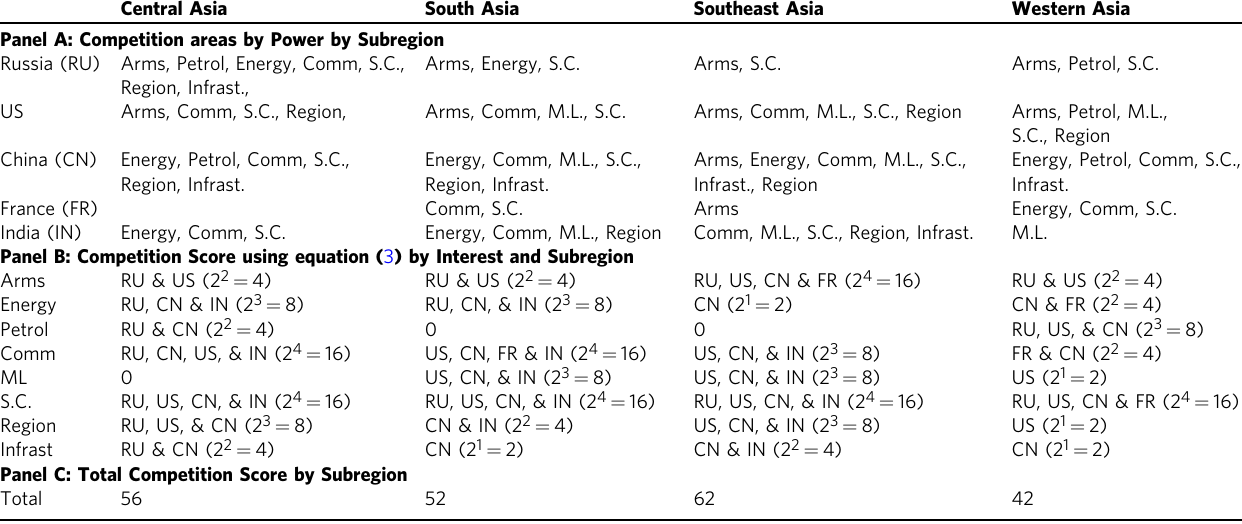
Table 3 Competition information and score by powers, interests, and subregions in Asia.